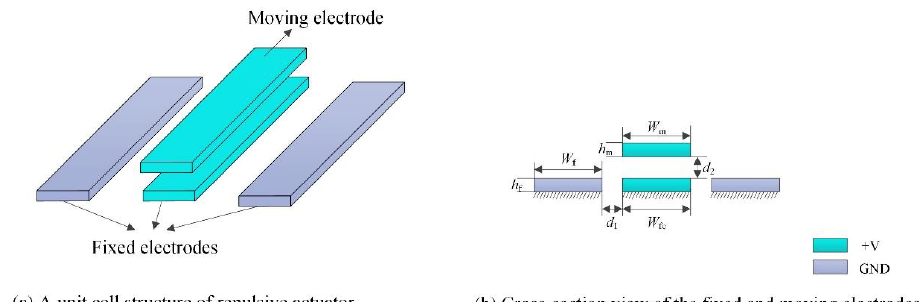
Figure 2. Schematic diagram of the electrostatic repulsive actuator. ( a ) A unit cell structure of repulsive actuator; ( b ) Cross-section view of the fixed and moving electrodes.